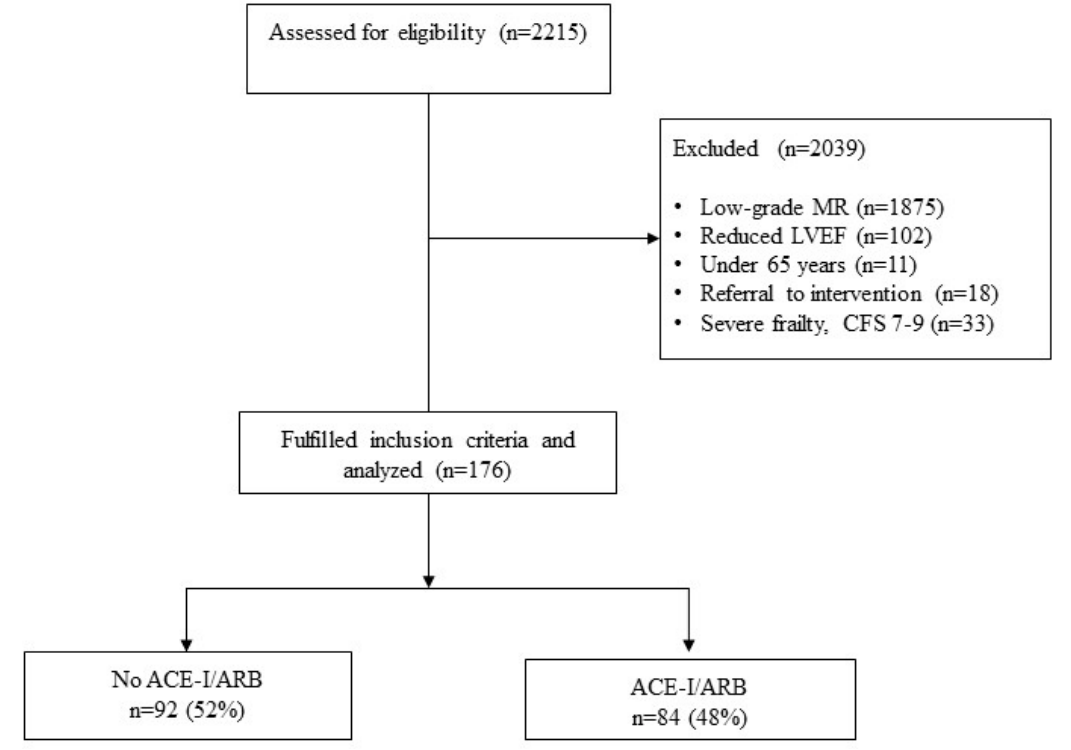
Figure 1. Flowchart of patient inclusion. Abbreviations: MR mitral regurgitation, LVEF left ventric- ular ejection fraction, CFS clinical frailty scale, ACE-I/ARB ACE-inhibitors and angiotensin receptor blockers.